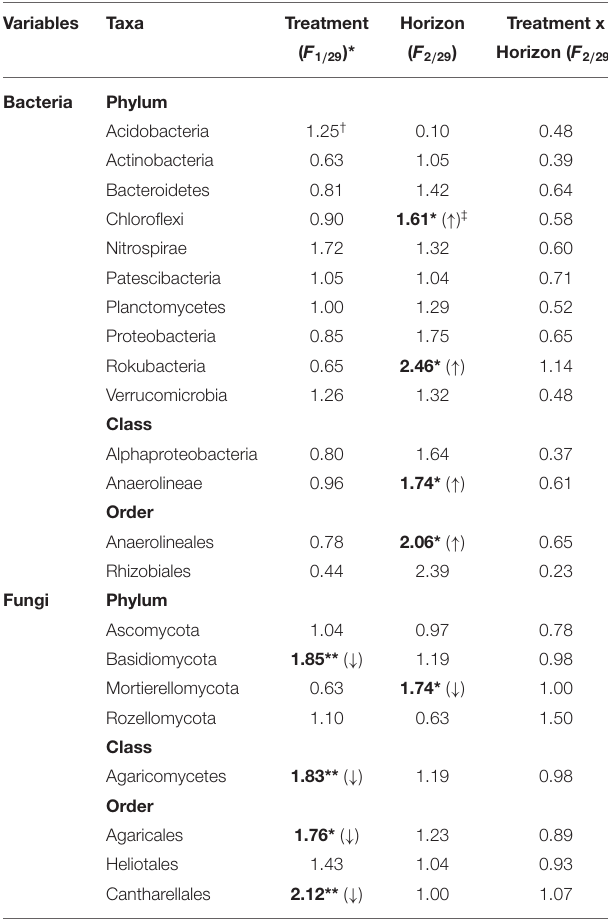
TABLE 3 | Treatment (N addition) and spatial (horizon) effects on the relative abundance of bacteria and fungi in the Alptal N addition experiment.